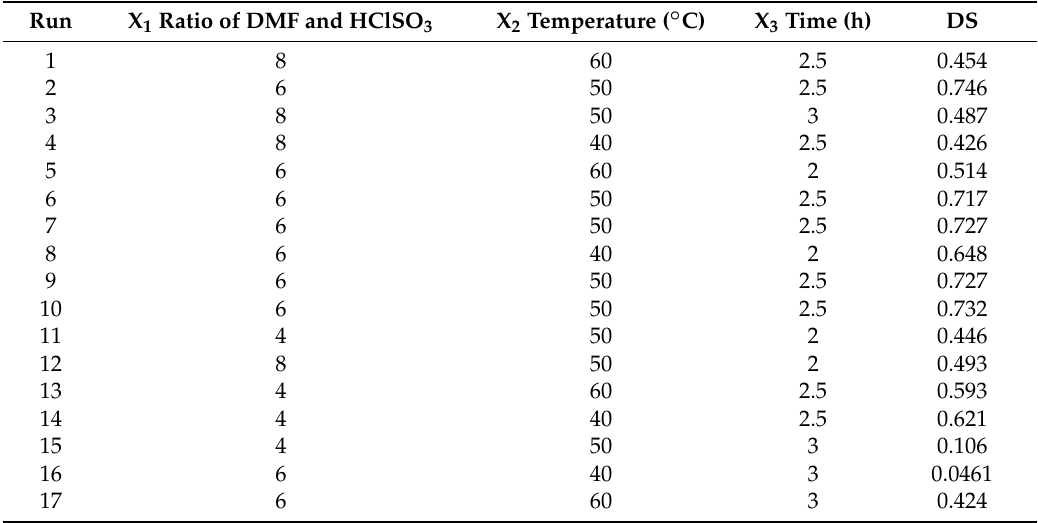
Table 1. Three factor central composite design matrix and the response values for DS of SYG. Run X 1 Ratio of DMF and HClSO 3 X 2 Temperature ( ◦ C) X 3 Time